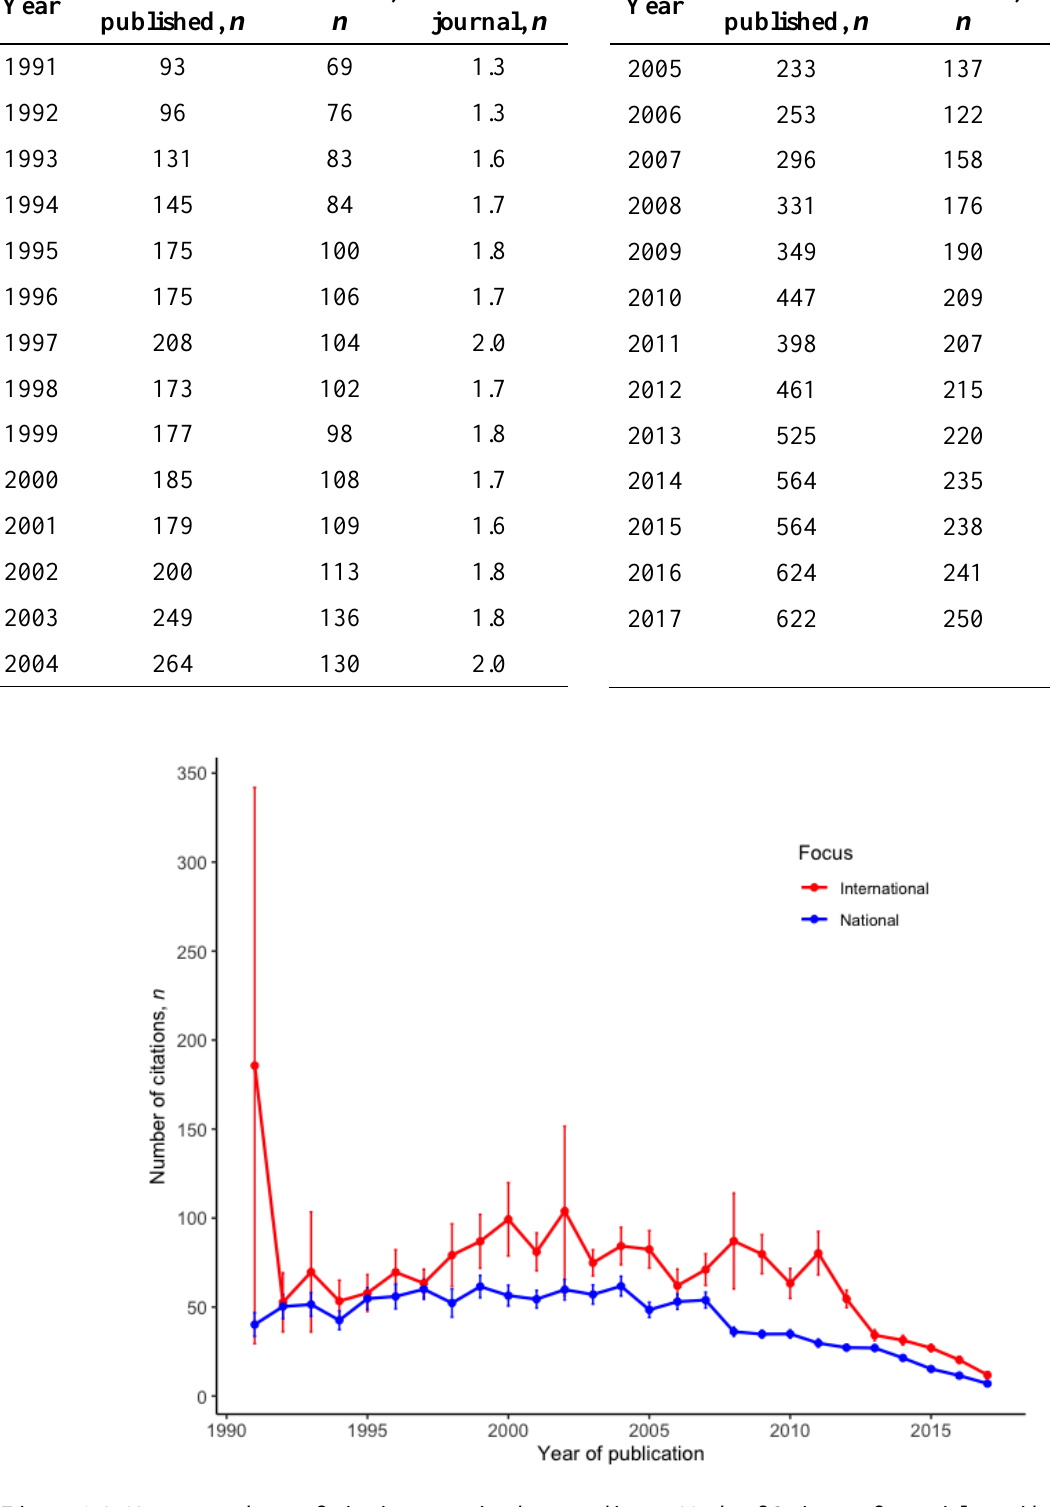
Figure A1. Mean numbers of citations received, according to Web of Science, for articles with at least one study site abroad (relative to the country of the affiliation) and articles based only on domestic study sites, according to the year of publication. Vertical bars represent ± 1 standard error of the mean. The 1991 extreme value for articles with at least one study site abroad is caused by 2996 indexed citations of Gorham